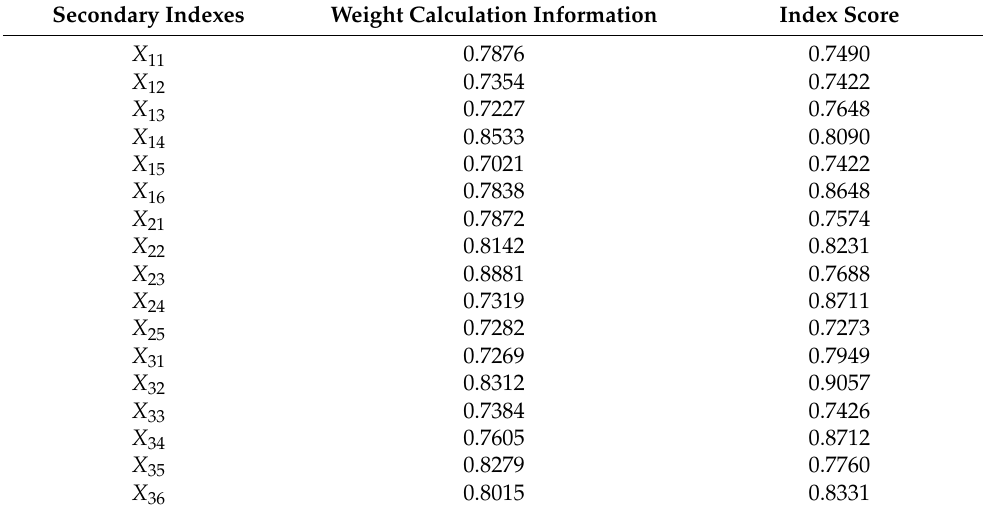
Table A1. Cronbachs’ α coefficients of valid questionnaires.